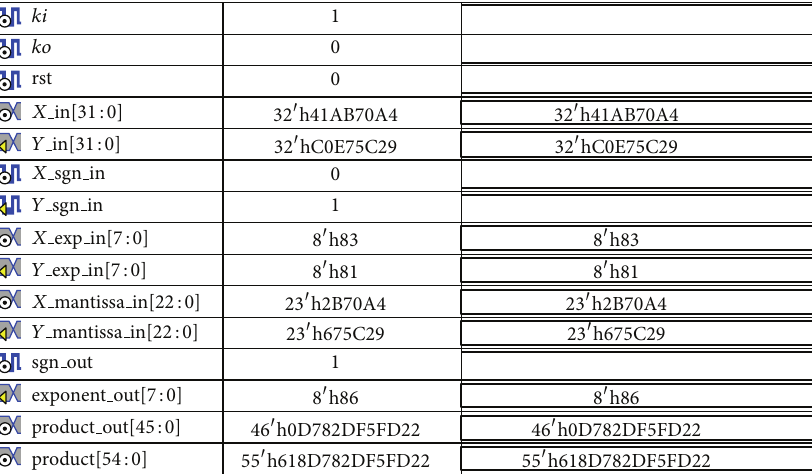
Figure 12: Simulation waveform of NCL FPM.